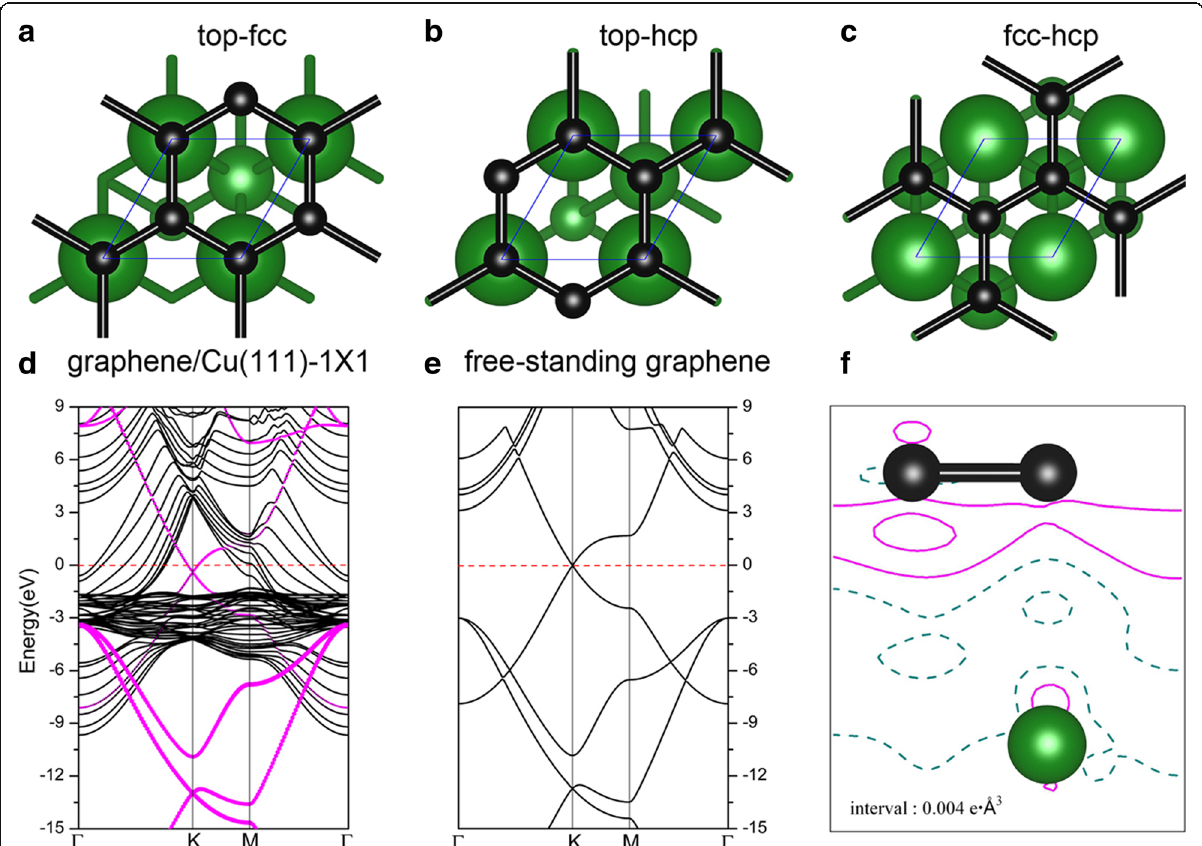
Fig. 6 Geometry of graphene sheet on the Cu(111) surface: a top-fcc, b top-hcp, and c fcc-hcp sites. d Band structures of graphene/Cu(111) system in the top-fcc geometry, compared with e those of free-standing graphene. The magenta points indicate the electronic states contributed from graphene. f The charge differences between total charge density of graphene/Cu(111) and the sum of the charge densities of the independent graphene and the clean Cu(111) surface for the top-fcc geometry. The interval of the contour line is 0.004e Å −